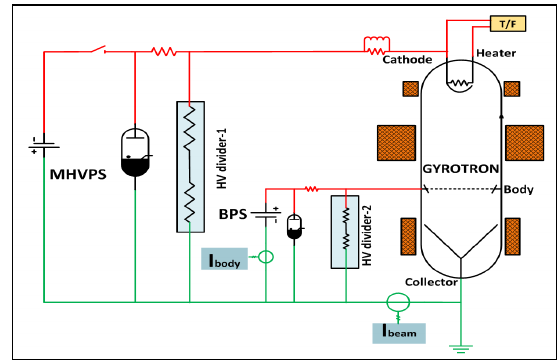
Fig. 3 : IIGTF HV Power Supply configuration